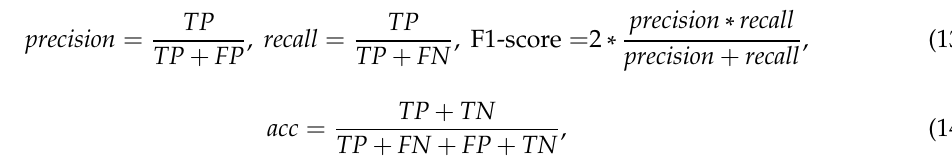
Figure 14. Image transformation of slag inclusion defect.